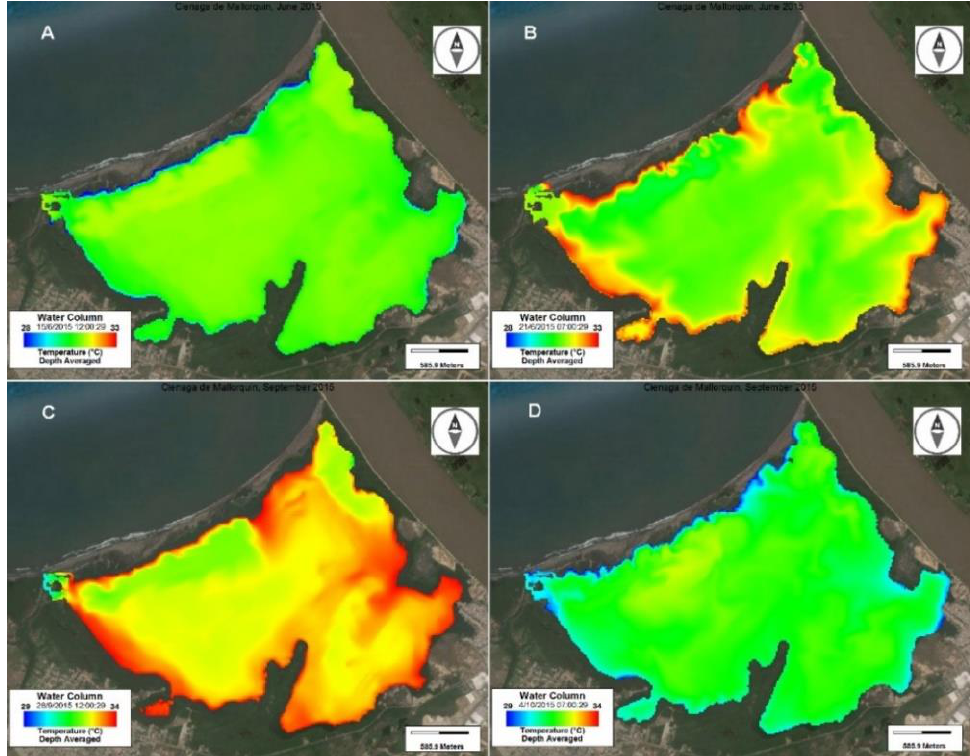
Fig. 5: Simulation of temperature variation. A) Transition Period (0.5 days of simulation). B) Transition Period (6 days of simulation). C) Wet season (0.5 days of simulation). D) Wet season (6 days of simulation) (wet season: note the change in scale